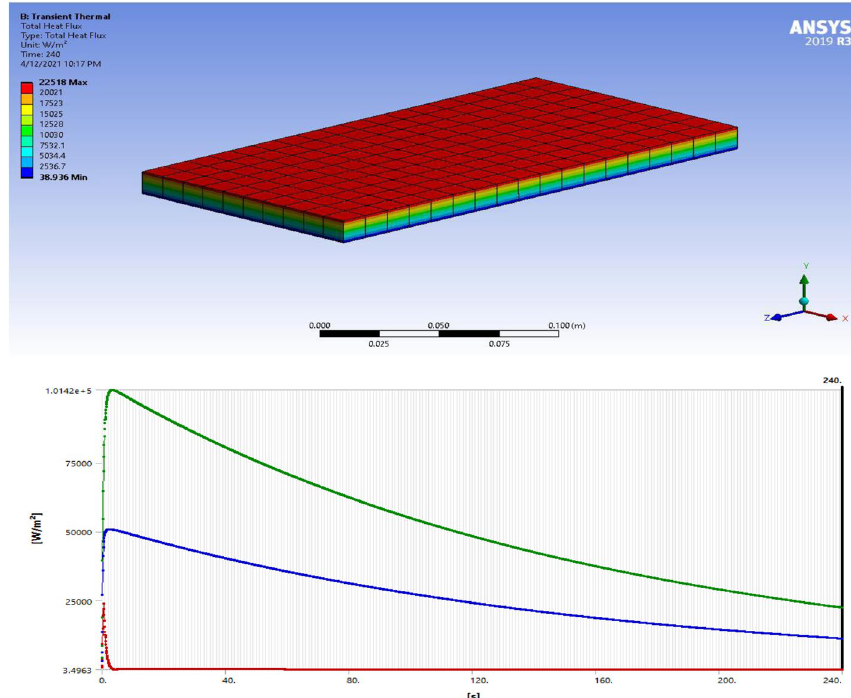
Fig. 11 CFD heat flux model and time plot at 150 °C, D